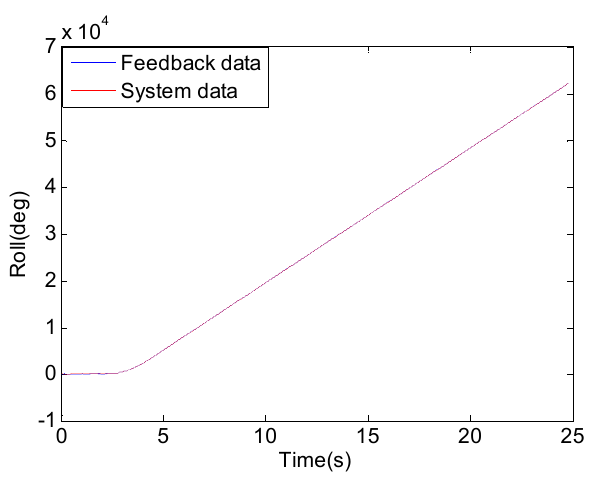
Figure 18. Roll Figure 18. Roll attitude.